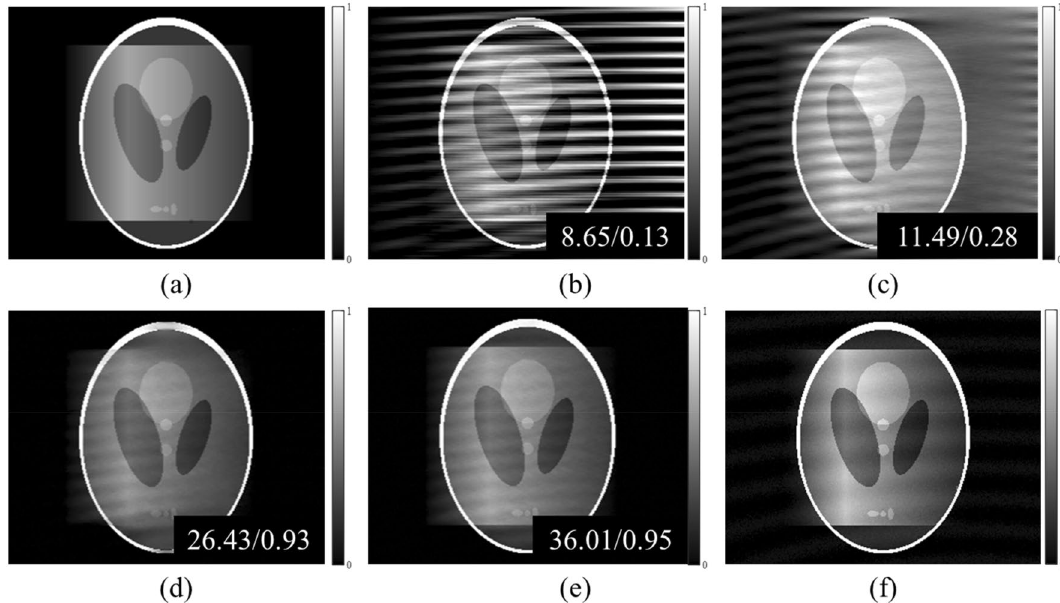
Figure 3. Comparison results for numerical phantom image. ( a ) Reference, ( b ) direct integration, ( c ) Wavelet- Fourier filtering, ( d ) iterative method, ( e ) The proposed method, ( f ) transmission. The display window for ( f ) is [0, 0.1], the others is [0, 1], respectively. The PSNR and SSIM values are displayed in the